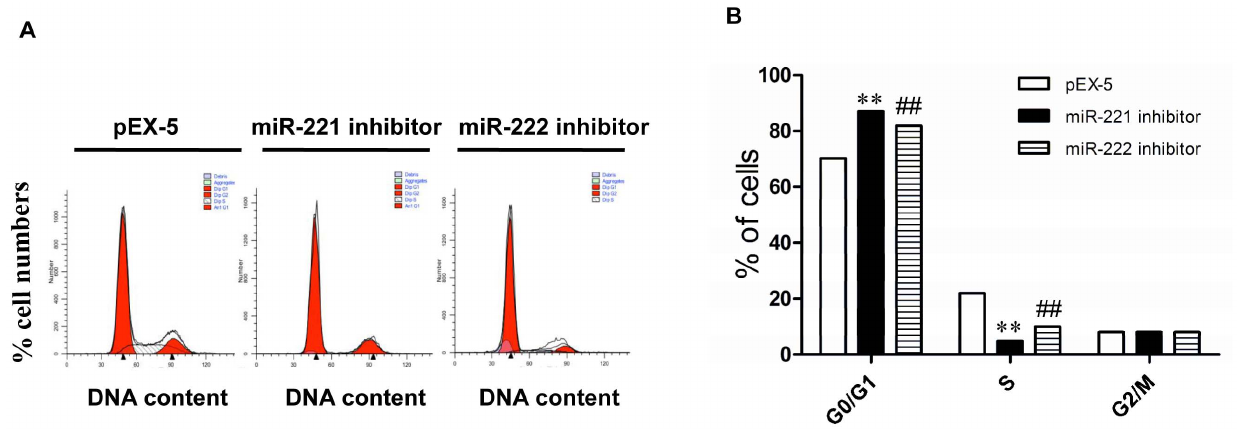
Figure 3. Effects of miR-221 inhibitor and miR-222 inhibitor on PC-3 cell cycle distribution. ( A ) Cell DNA content distribution in each phase. ( B ) Percentage of cells distributed in each phase of the cell cycle. **, ## P , 0.01 vs